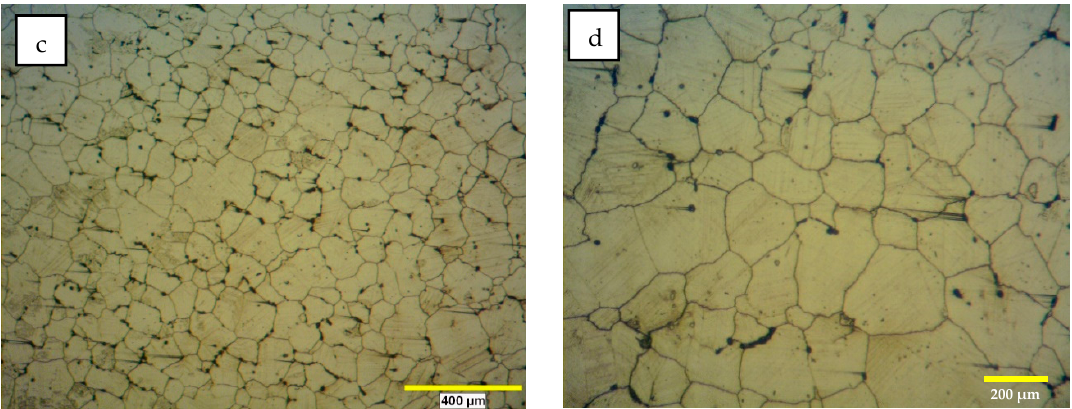
Figure 2. ( a,b ) and ( c , d ) Optical micrographs of the fine recrystallized grains nucleated in the vicinity of carbide particles for 15 and 30 min, respectively.